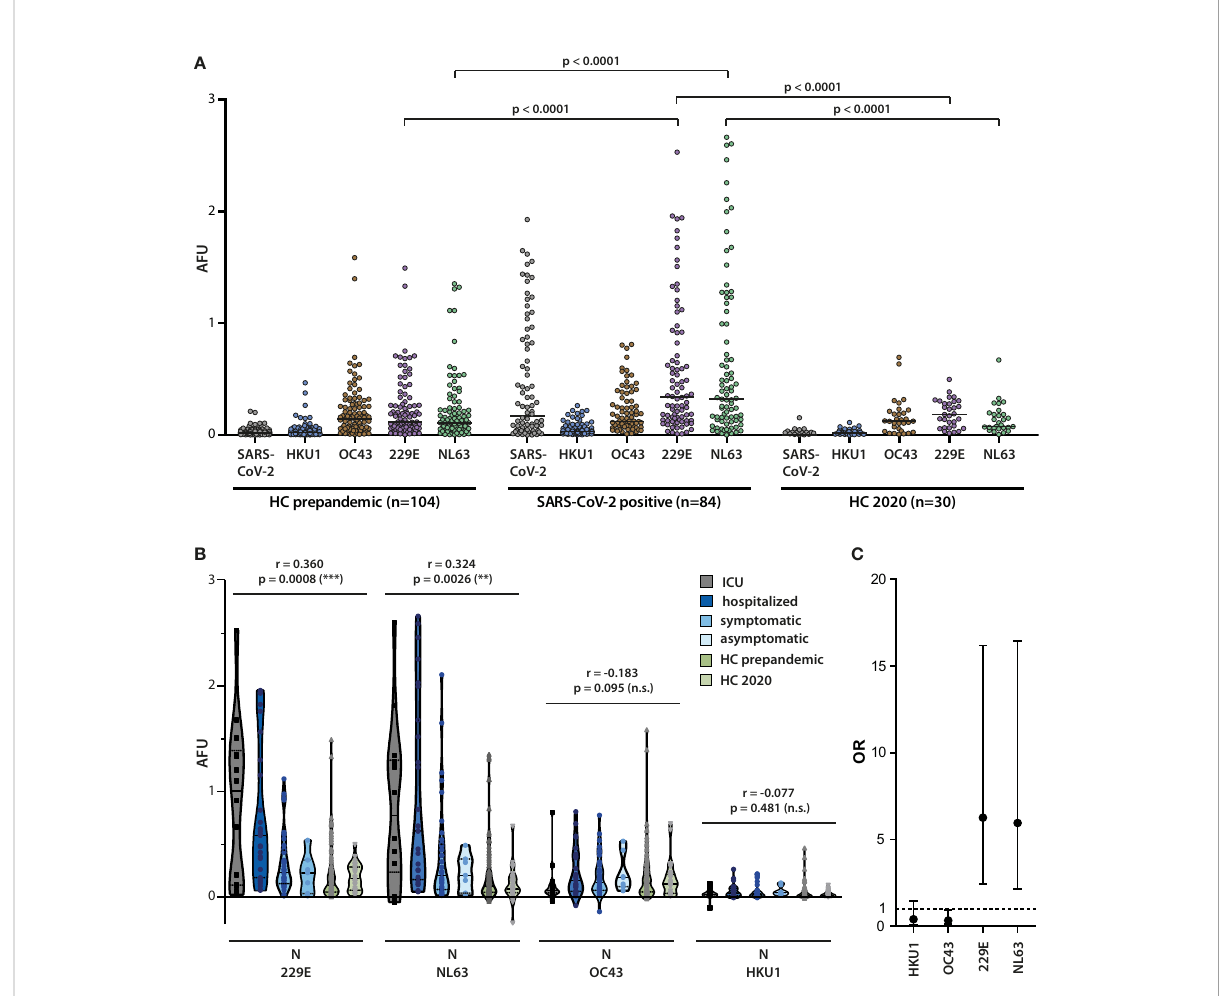
FIGURE 6 Correlation of alphacoronavirus N-speci fi c IgG responses with COVID-19 severity. (A) The magnitude of the IgG antibody response against N of SARS-CoV-2 and the endemic coronaviruses HKU1, OC43, 229E, and OC43 was measured in sera from SARS-CoV-2 infected donors (n=84) and healthy controls (n=104) collected in 2018/2019 (HC pre-pandemic) as well as from healthy controls (n=30) collected in 2020. Mean values are indicated by horizontal lines. Results of Mann-Whitney U test are depicted. (B) Correlation of antibody responses with disease severity. Antibody responses against N of the indicated endemic coronaviruses were analyzed in the four indicated patient cohorts and healthy controls. Spearman correlation coef fi cient and p values are displayed. (C) Odds ratios (OR) for the association of serum responses to individual alpha- and betacoronavirus N proteins with hospitalized versus non-hospitalized infection events are shown along with the 95% con fi dence intervals. The serum response cutoff values used for calculating the OR were determined by Youden-Index maximization on ROC curves for individual N- speci fi c IgG responses. Sensitivities (se) and speci fi cities (sp) for the applied cutoffs were as follows: 229E se 68%, sp 74%; NL63 se 54%, sp 84%; OC43 se 63%, sp 16%; HKU1 se 10%, sp